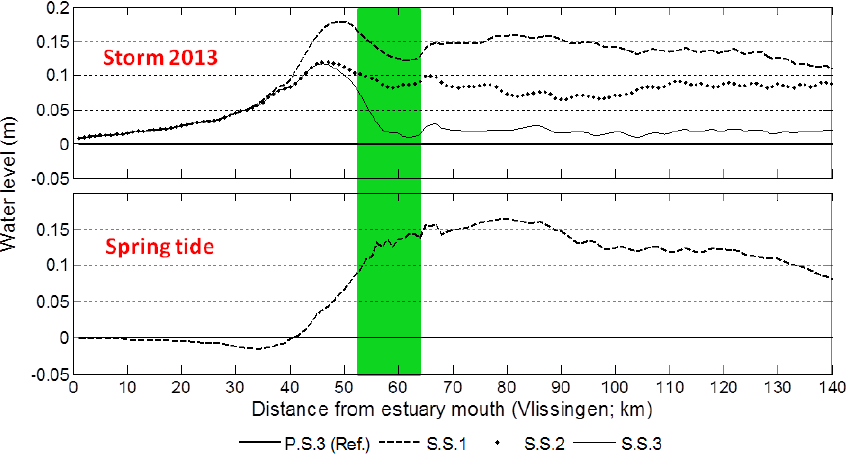
Figure 9. Scenarios for different schematic surface areas relative to reference scenario P.S.3. Scenarios given for a spring tide and the storm tide of 2013. For spring tide all scenarios gave nearly the same result. The green area in the figure shows the location of the Saeftinghe wetland in the model.